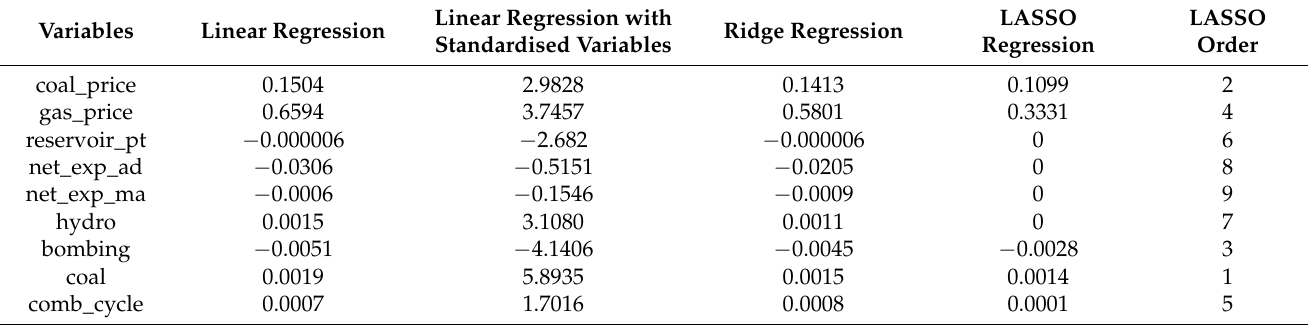
Table 1. Coefficient values for the linear regression algorithms and LASSO variable order. Linear Regression with Variables Linear Regression Standardised